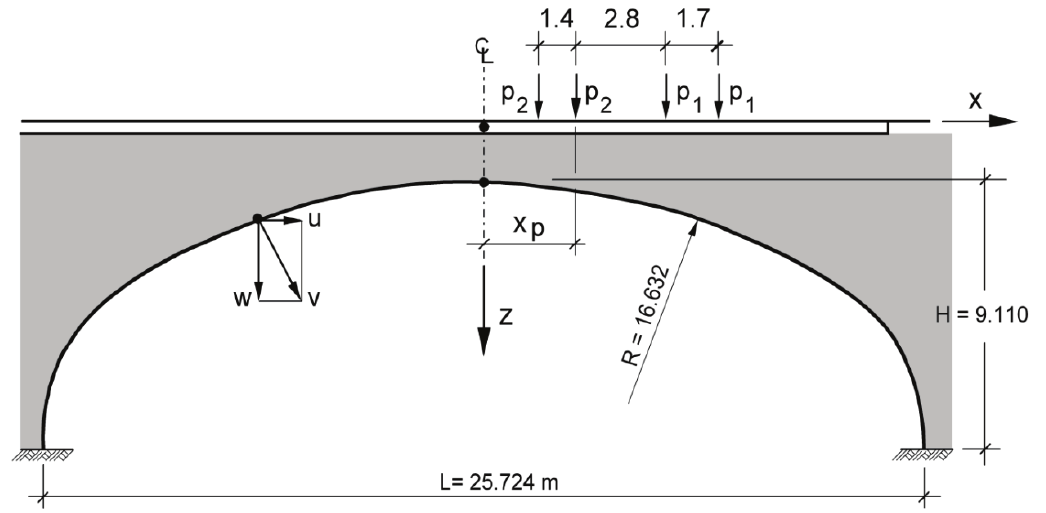
Figure 1: Cross-sectional geometry of soil–steel structure and truck location.